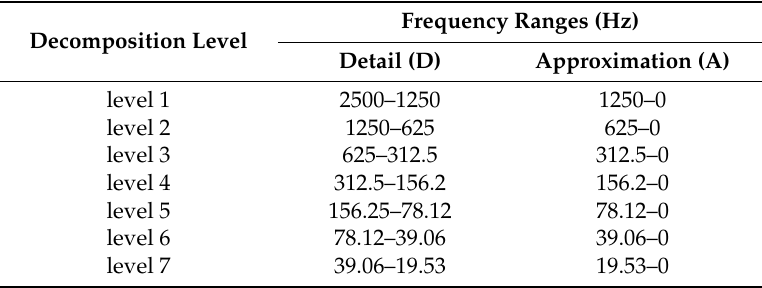
Table 1. Accordingly, the features evaluated for monitoring BRB faults in LS-PMSM are based on these relevant frequency bands. Table 1. Frequency ranges for the wavelet decomposition of the signal. Table 1. Frequency ranges for the wavelet decomposition of the signal.